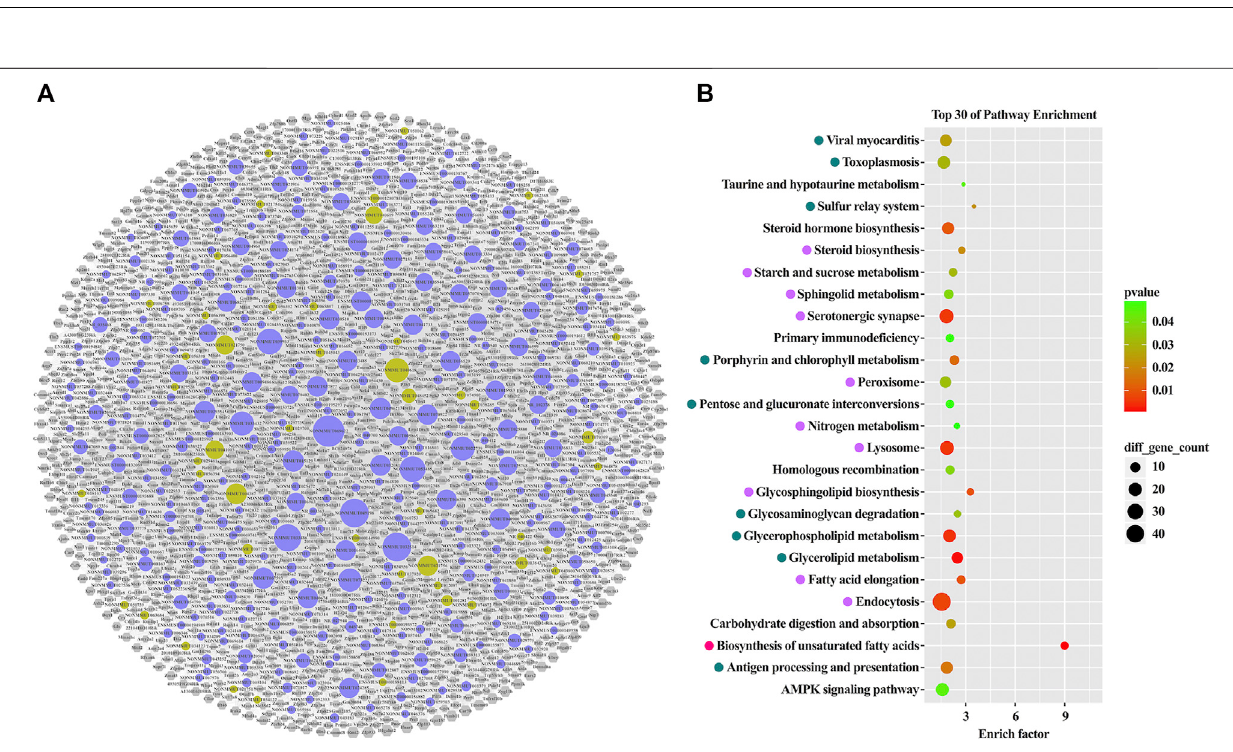
Frontiers in Physiology |